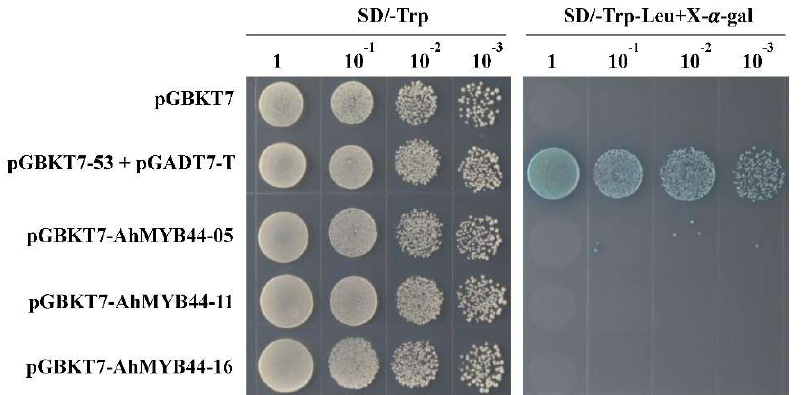
Figure 3. Transcriptional activation analysis of AhMYB44s in yeast. The recombinant vectors pGBKT7-AhMYB44-05/11/16 were transferred into yeast strain AH109. Their transcriptional activation ability was analyzed by growth on SD/-Trp and SD/-Trp-Leu with X-α-gal plates. pGBKT7: negative control; pGBKT7-53+pGADT7-T: positive control.